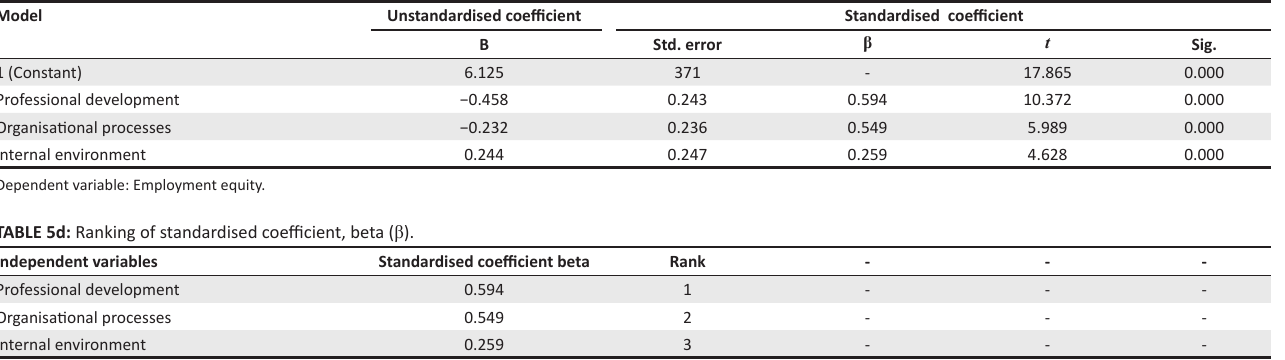
TABLE 5c: The coefficients and ranking of standardised coefficients. Model